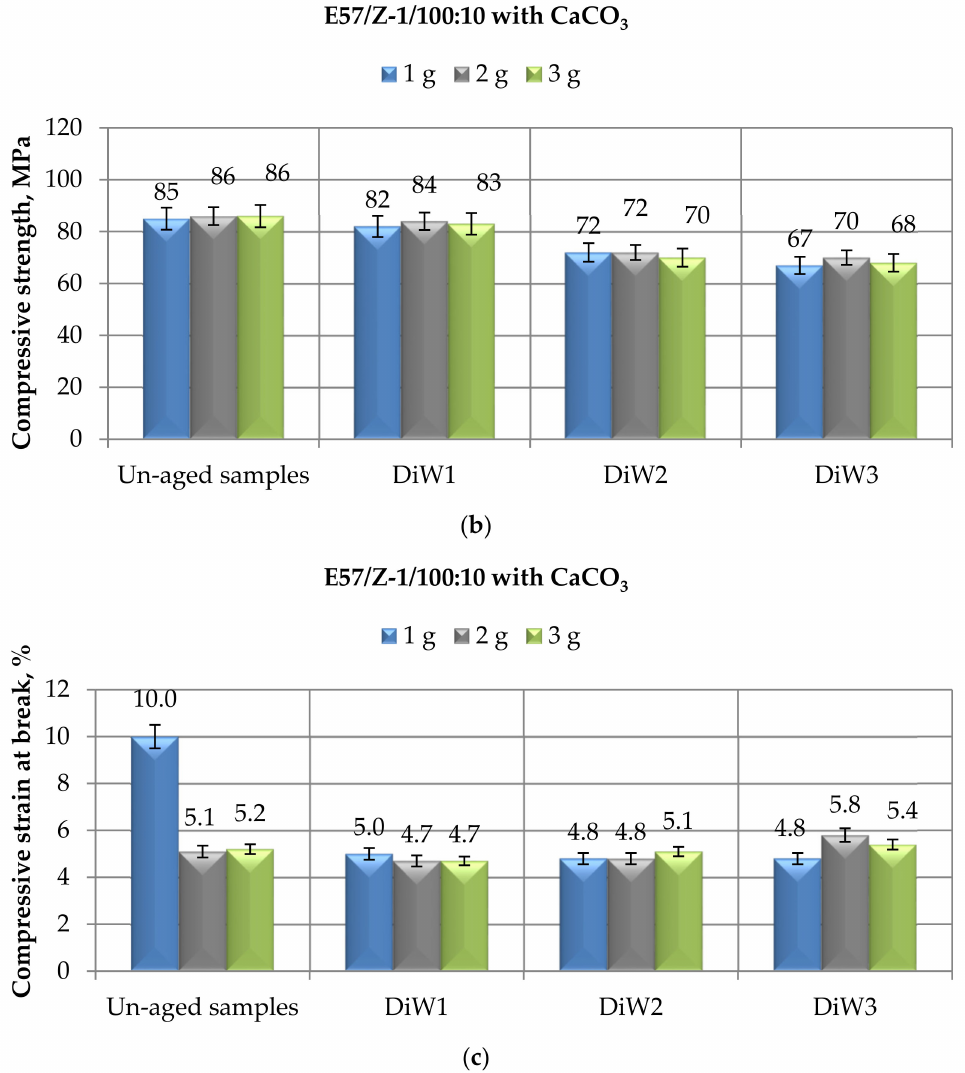
Figure 7. Results of mechanical tests performed in compression mode on CaCO 3 -filled E57/Z-1/100:10 specimens after different immersion times (i.e., 1, 6, and 10 months) in distilled water, in terms of ( a ) Compressive modulus; ( b ) Compressive maximum strength; ( c ) Compressive strain at